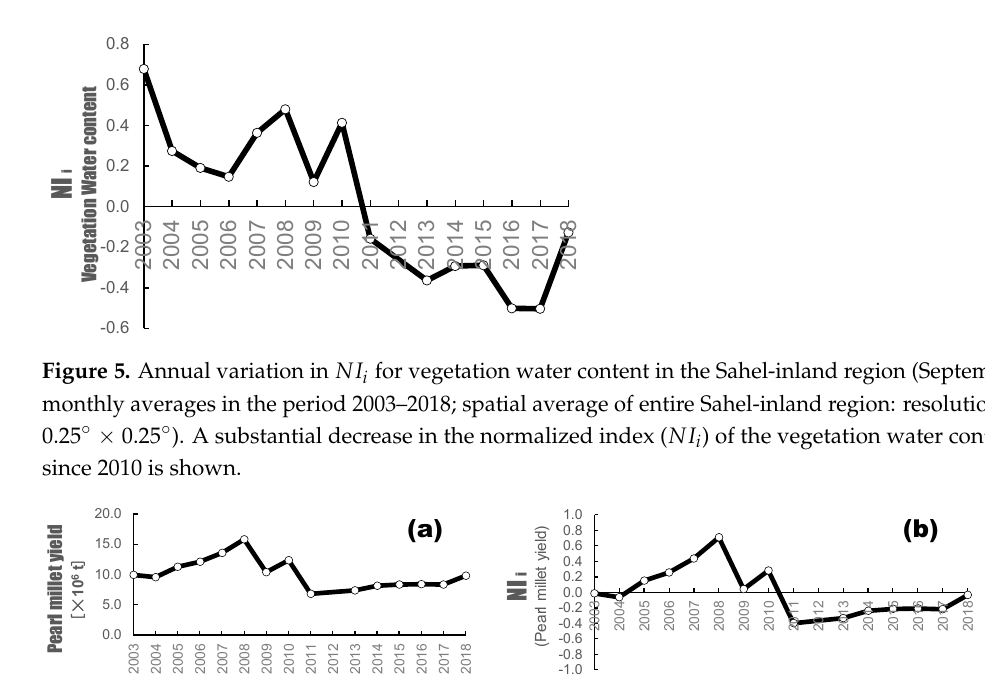
Figure 6. Annual variation in the pearl millet yield in the Sahel-inland region consisting of Chad, Niger, Nigeria, Benin, Burkina Faso, and Mali: ( a ) pearl millet yield, and ( b ) its normalized index ( NI i ), decrease in pearl millet yield since 2011 is clearly shown.